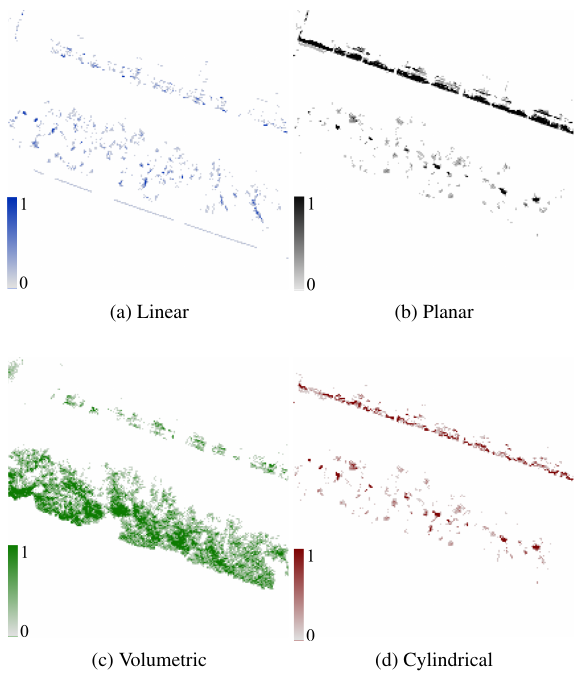
Figure 8: Accumulation maps